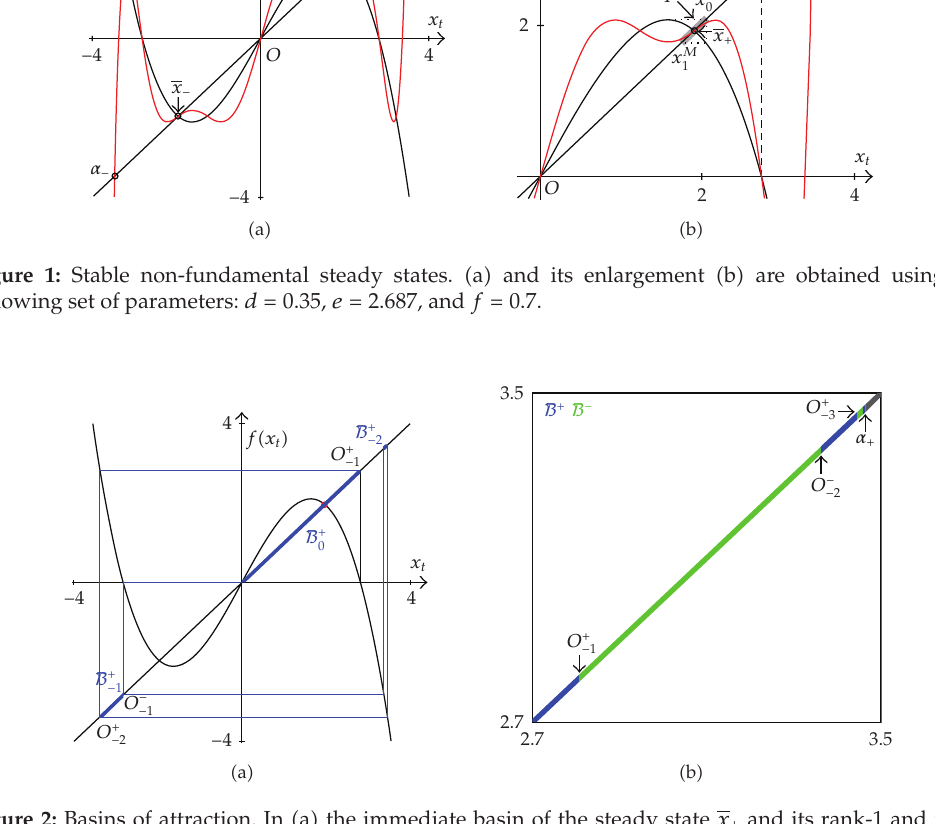
Figure 2: Basins of attraction. In (cid:5) a (cid:6) the immediate basin of the steady state x (cid:7) and its rank-1 and rank- 2 preimages are represented in blue. In (cid:5) b (cid:6) an enlargement of the interval between O − 1 (cid:7) and α (cid:7) with the alternance of intervals belonging to the basin of attraction of x (cid:7) (cid:5) in blue (cid:6) and x − (cid:5) in green (cid:6) are shown. The parameters are as in Figure